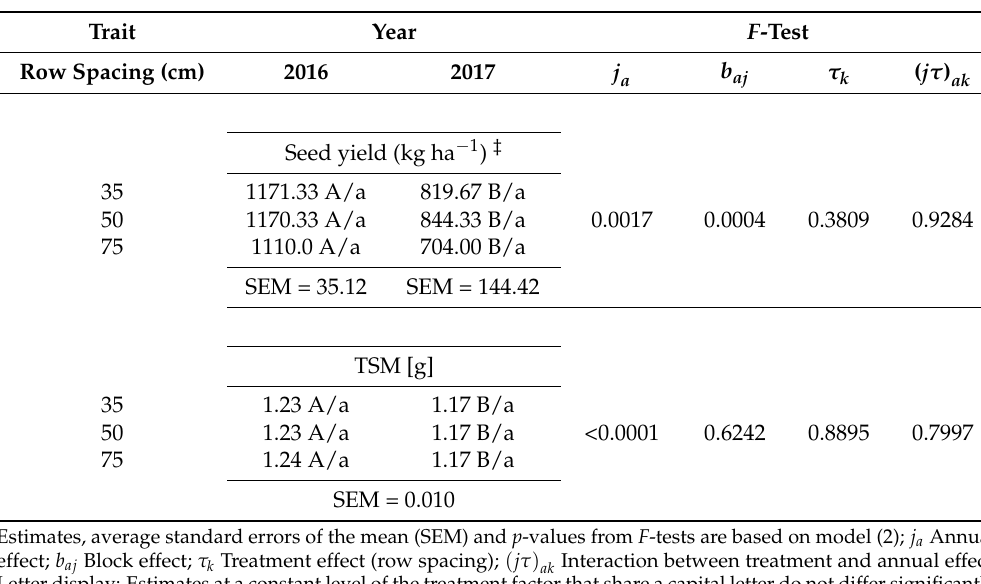
Table 3. Estimated seed yield (kg ha − 1 ) and thousand seed mass (TSM) (g) of chia (Genotype G8) based on model (2) cultivated at three different row spacing (35, 50, 75 cm) at Ihinger Hof in 2016 and 2017, along with standard error of the mean (SEM) and F -tests ( n = 3, α = 0.05). Trait Year F -Test b aj τ k ( j τ ) Row Spacing (cm) 2016 2017 j a ak Seed yield (kg ha − 1 ) ‡ 35 1171.33 A/a